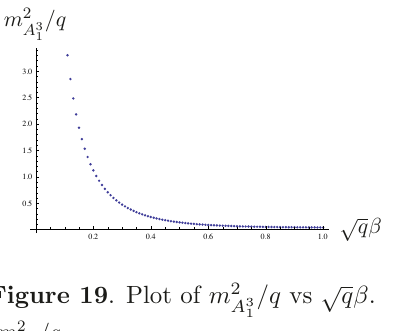
/q vs √ qβ . Figure 20 . Plot of m 2 A 3 1